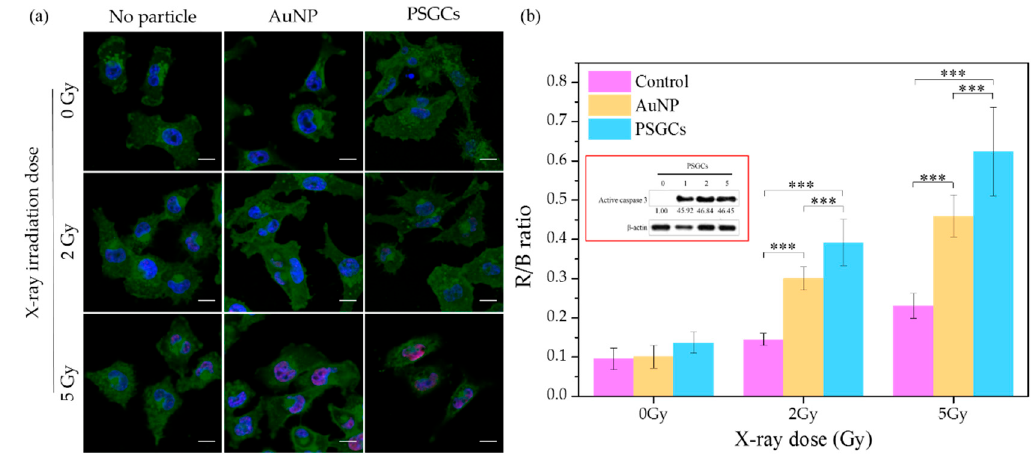
Figure 5. ( a ) Immunofluorescence staining of γ -H2AX (red) for MD-MBA-231 cells treated with AuNPs and PSGCs after 0, 2, and 5 Gy X-ray irradiation. Scale bar is 15 µ m. ( b ) Quantitative fluorescence intensity ratio of γ -H2AX to nucleus (red/blue, R/B) for MD-MBA-231 cells treated without and treated with AuNPs and PSGCs after irradiation at 0, 2, and 5 Gy. Inset shows the immunoblotting analysis of caspase 3 protein expression for cells treated with PSGCs after 0, 1, 2, and 5 Gy X-ray irradiation. Statistical significance is denoted as follows: *** represents a p value ≤ 0.001. NS indicates that a value is not statistically significant.